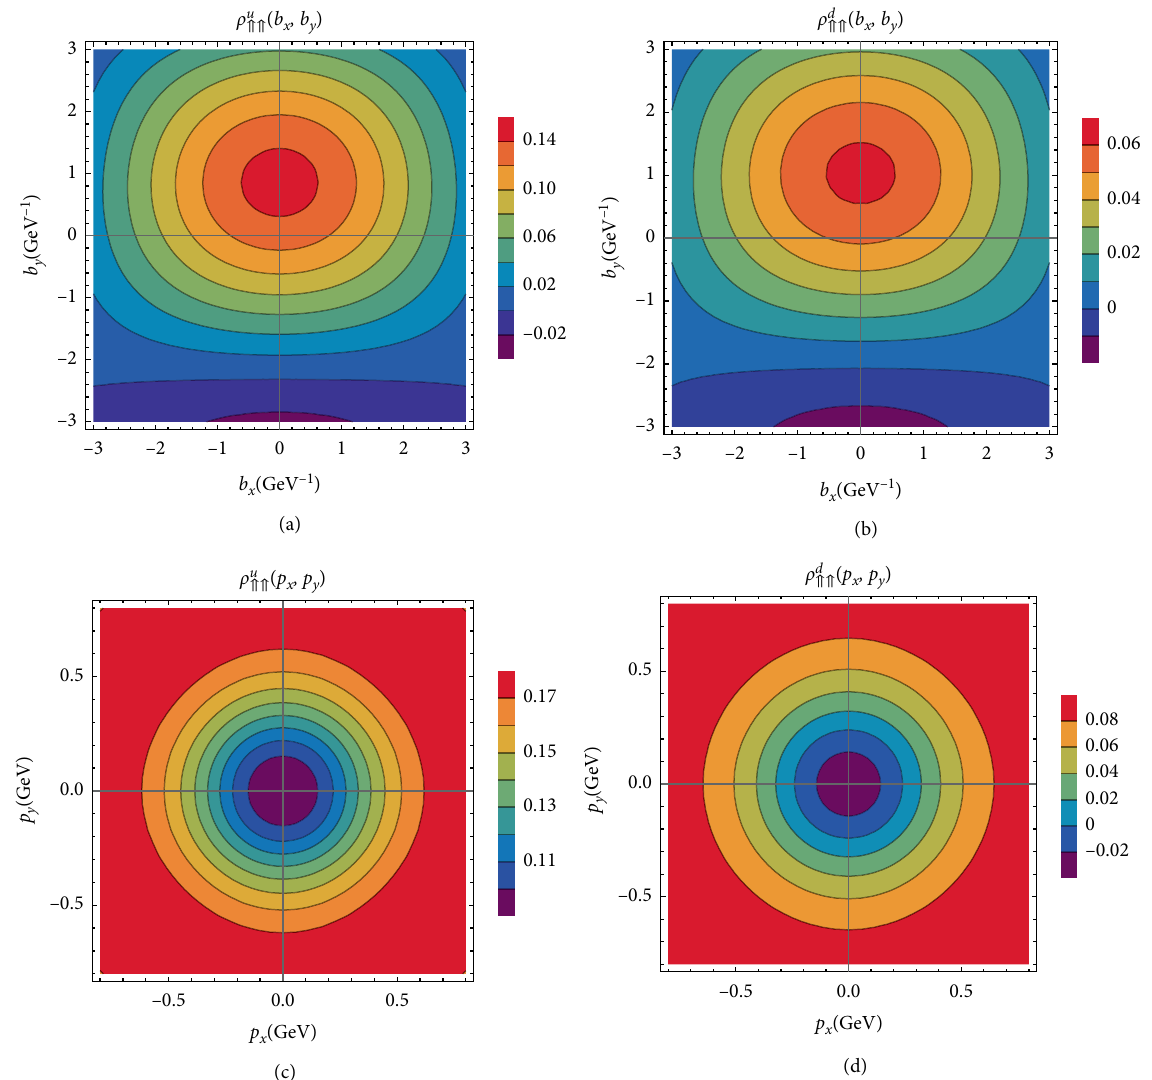
( b , p ) in transverse impact-parameter plane and transverse momentum plane for 𝑢 -quark ⇑⇑ ⊥ ⊥